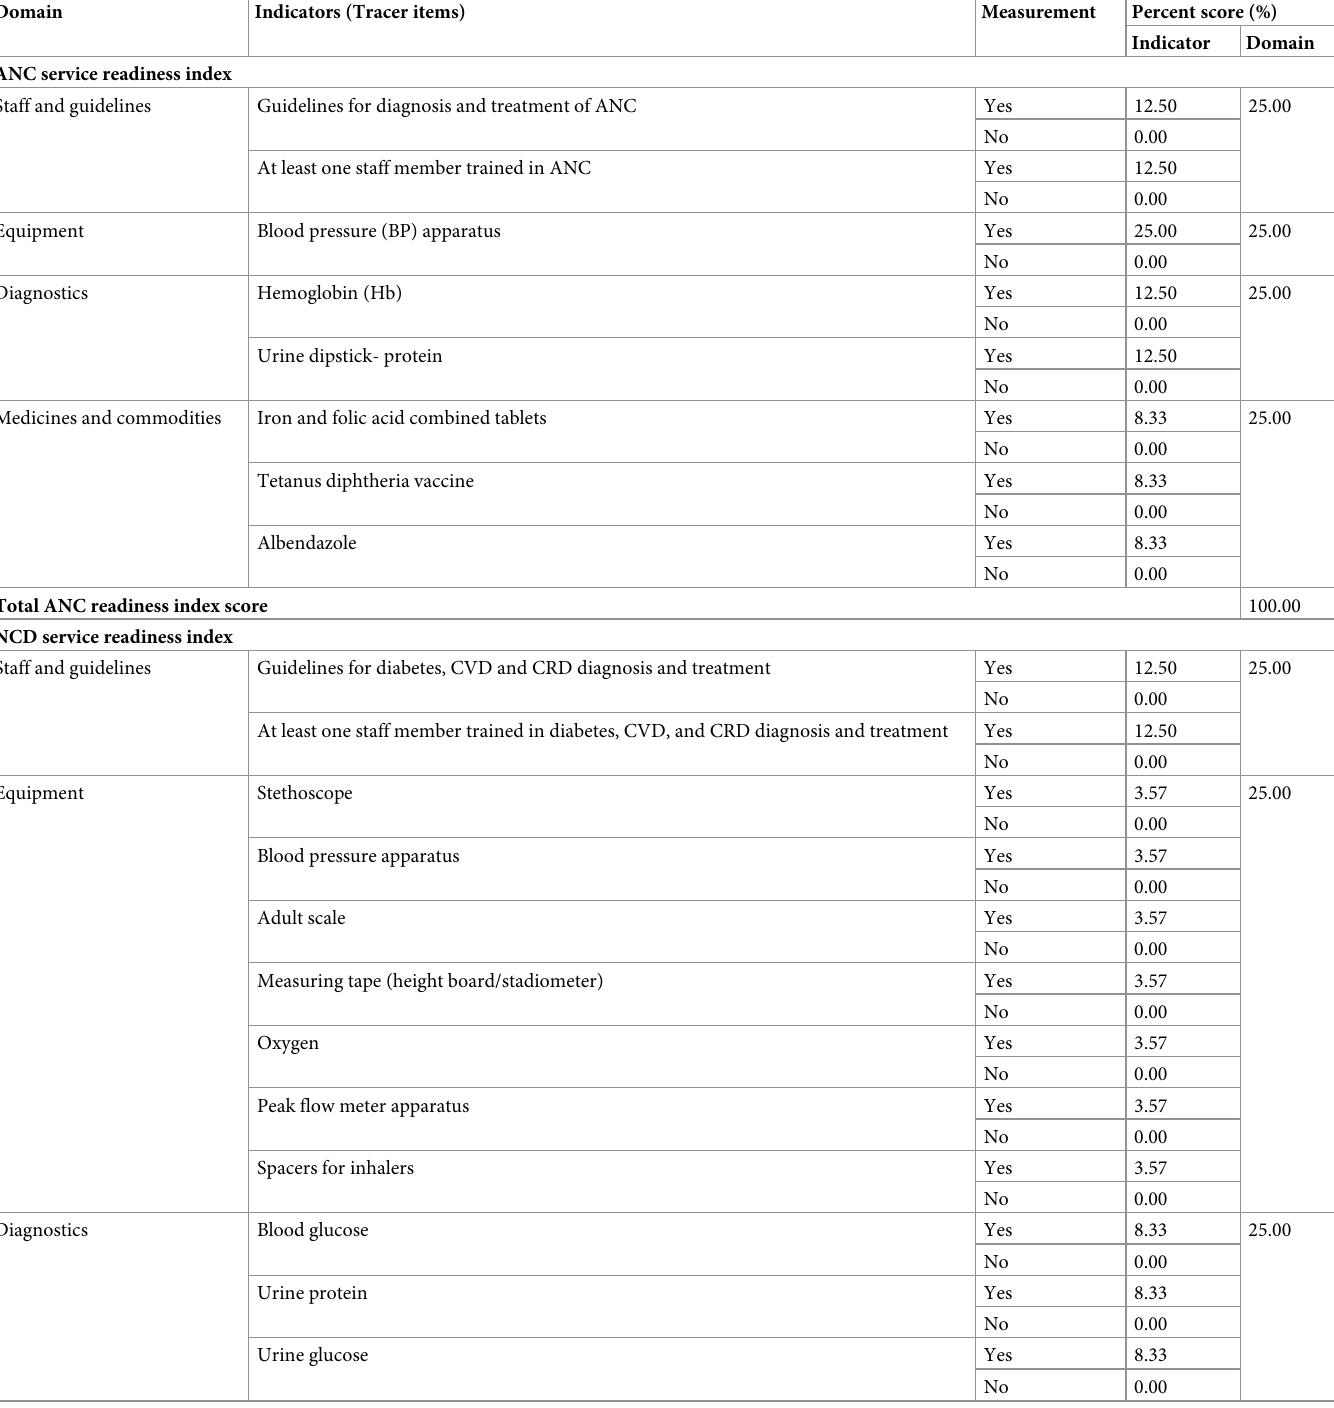
Table 2. Summary of readiness domains, indicators, and measurement procedure of ANC and NCD service readiness score for health facilities.